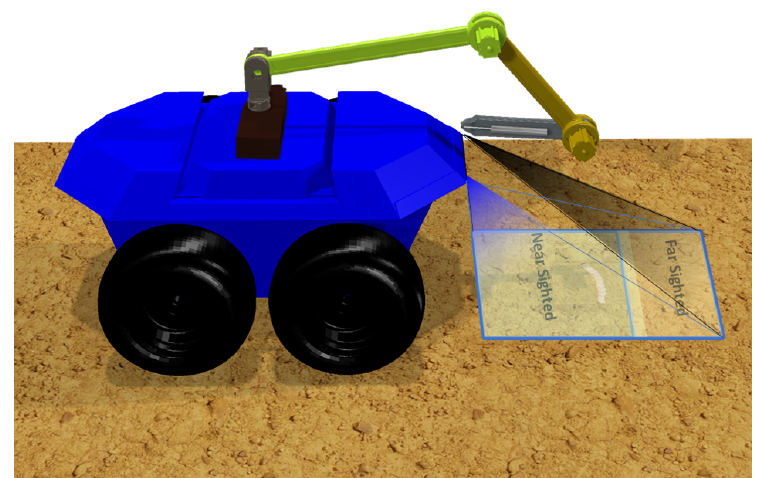
Figure 12. The adopted mobile manipulator in the CoppeliaSim scene for validating the proposed insect pest recognition mechanism.